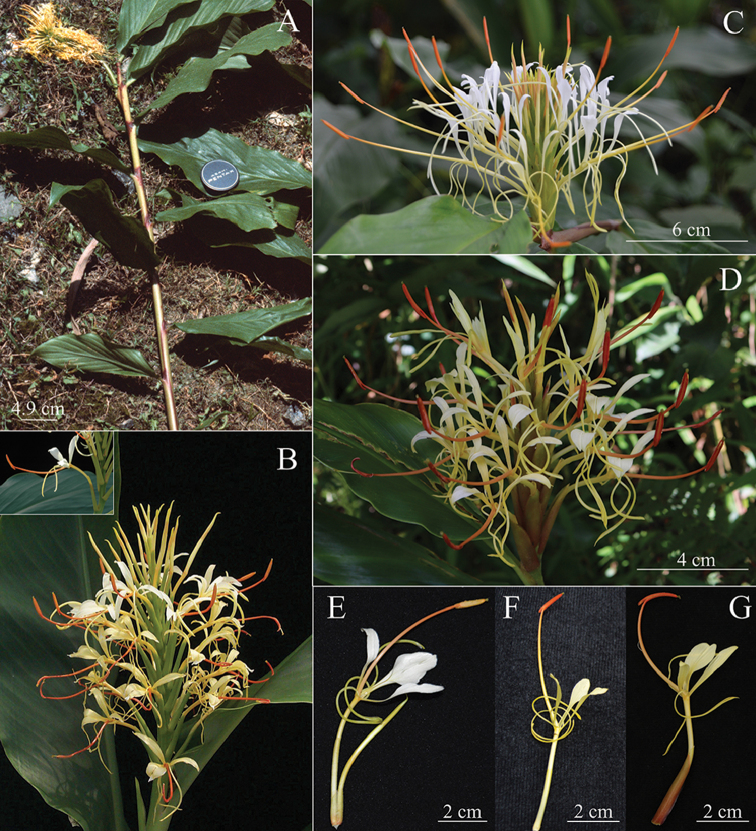
AHedychiumgriersonianumB Inflorescence of H.yunnanense (flower in the inset) C Inflorescence of H.ellipticumD Inflorescence of H.gomezianumE Flower of H.ziroenseF Flower of H.ellipticumG Flower of H.gomezianum. Photo Credits: A Andrew Grierson. © Royal Botanic Garden Edinburgh 2018; B Leslie Brothers. © United States National Herbarium (US); C, E. Ajith Ashokan; D, F, G Preeti Saryan.